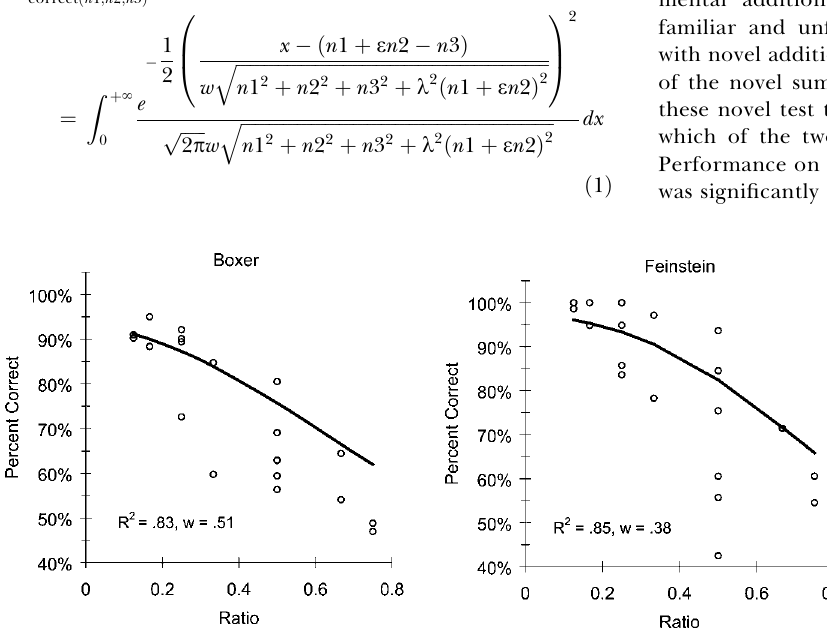
Figure 3. Monkeys’ Addition Performance Was Ratio-Dependent Both monkeys’ accuracy on each of the addition problems was modulated by the numerical ratio between the correct sum and the distractor choice. Solid lines show the predicted data from Equation 1. R 2 values reflect the fit between the predicted and actual data. w represents the precision with which monkeys selected the correct sum from the distractor choice based on the best fitting predicted data. As the ratio (small/large) between the sum and the distractor approached one, accuracy declined. Chance ¼